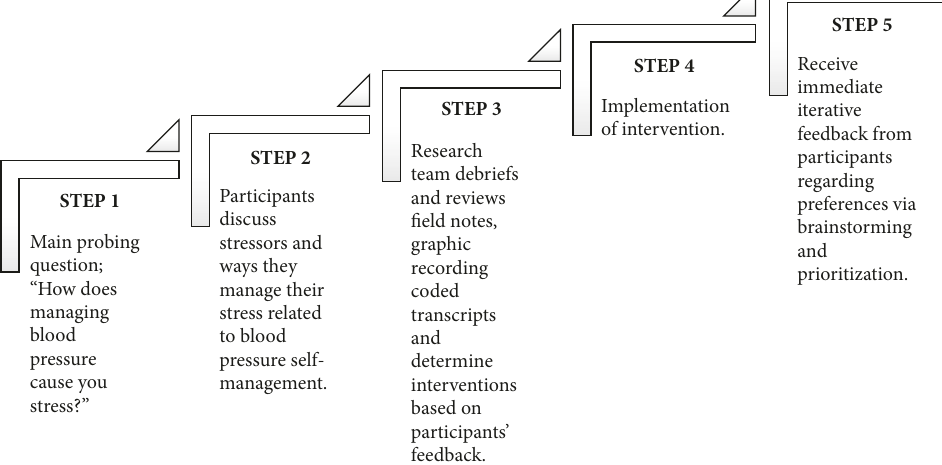
Figure 1: Steps to develop the cocreated intervention from focus group